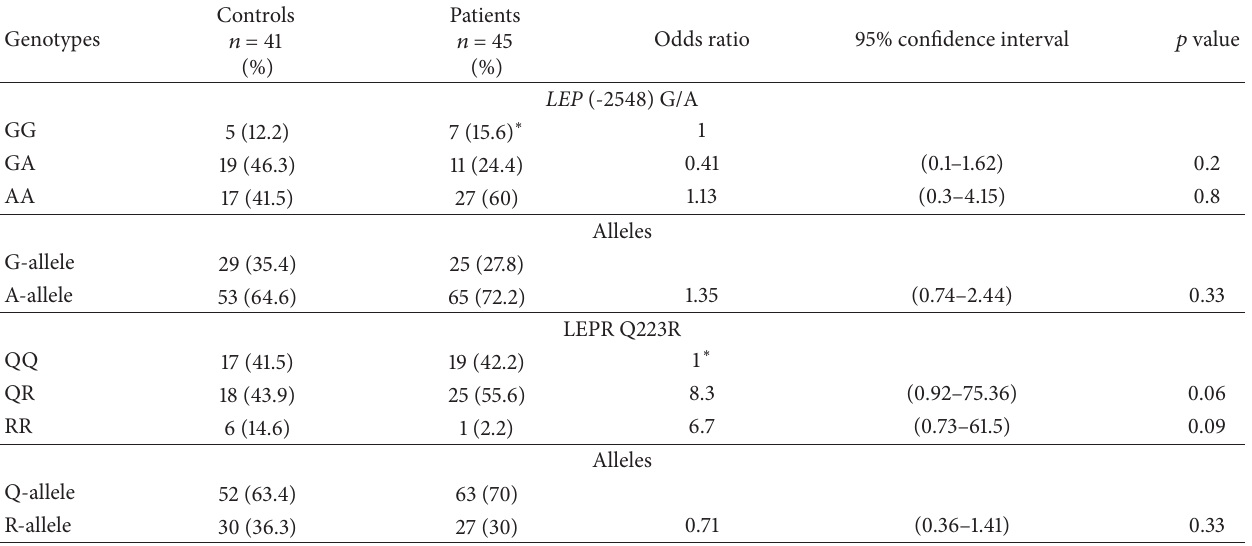
Table 2: Final results of -2548 G/A LEP and Q223R LEPR polymorphisms in the two groups of patients and controls with the risk of breast